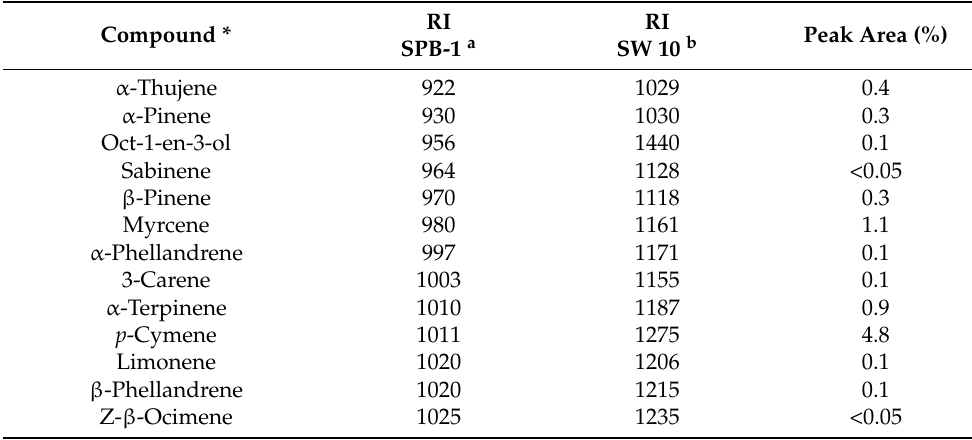
Table 1. Chemical composition of the essential oil from T. capitata